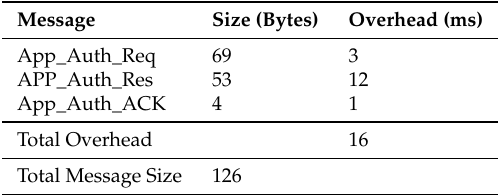
Table 11. Message size and overhead for the proposed protocol’s SEO.